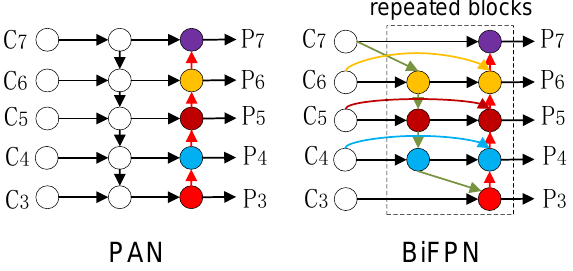
Figure 11. PAN used by YOLOv5 vs. BiFPN used by YOLOv5_CBS.